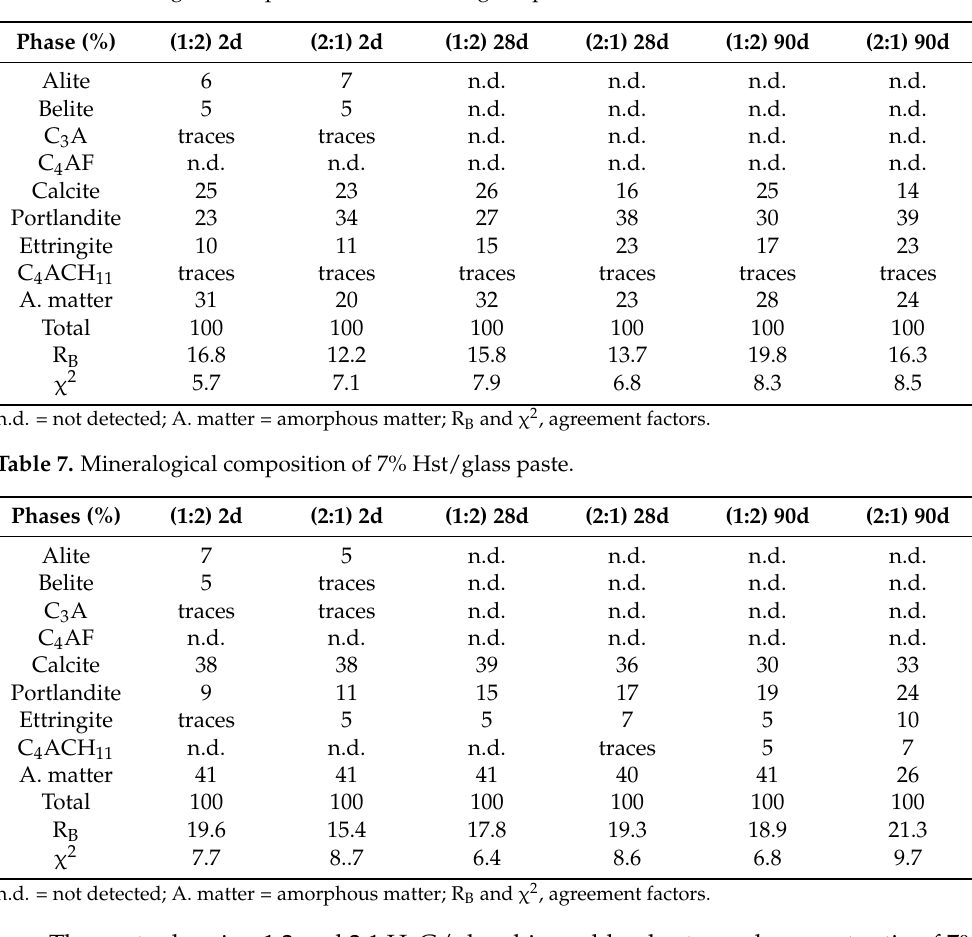
Table 6. Mineralogical composition of 7 % HcG/glass paste.